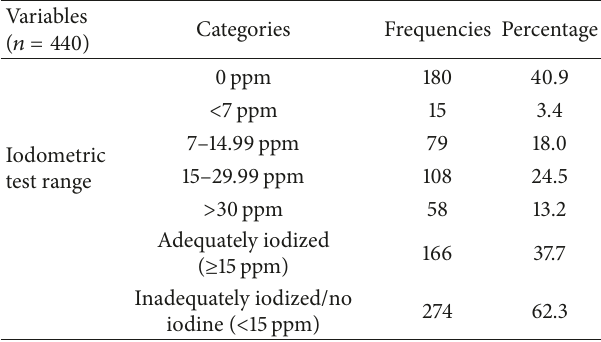
Table3:ChemistryofsaltsamplesfromhouseholdsinWolaitaSodo town and its peripheries, Southern Ethiopia